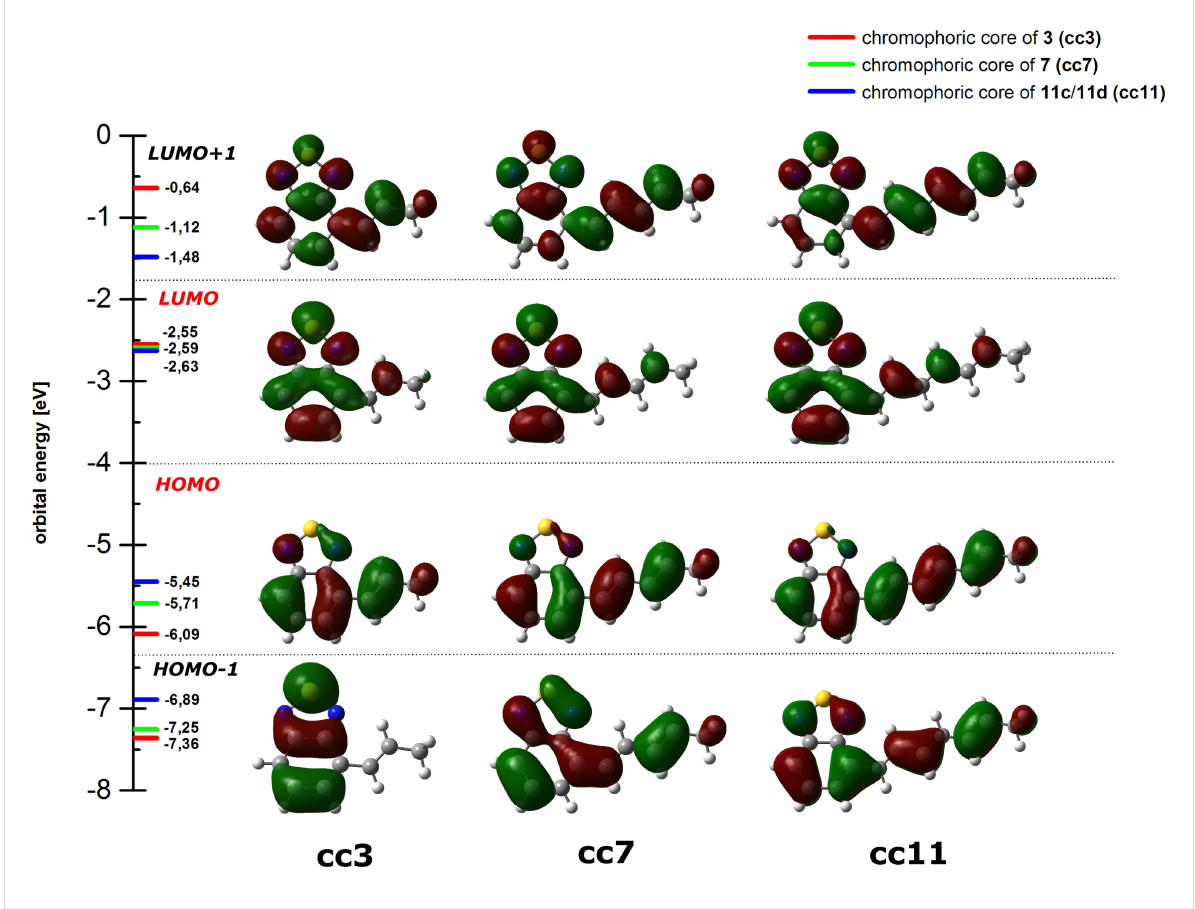
Figure 3: Frontier orbital energies (DFT) and their pictorial representation for the chromophoric cores (cc) of 3 , 7 , and 11 .